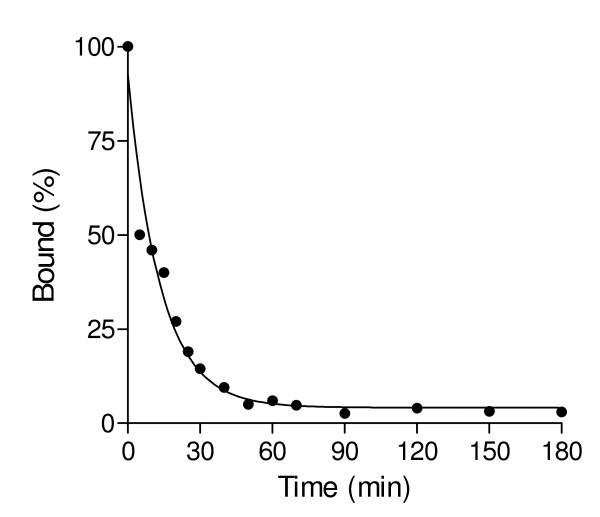
Dissociation kinetic for [3H]-QNB binding to rat control cerebral cortex membranes. Assay was performed at 30°C with 0.5 nM [3H]-QNB. At different time intervals (1 to 180 min), 3 ml samples were filtered and washed. Values represent a single experiment performed in duplicate.